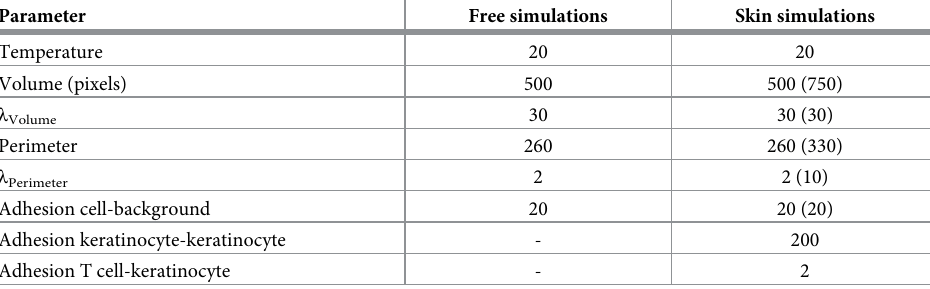
Table 1. CPM parameters used in the “free” and “skin” environments. Parameter